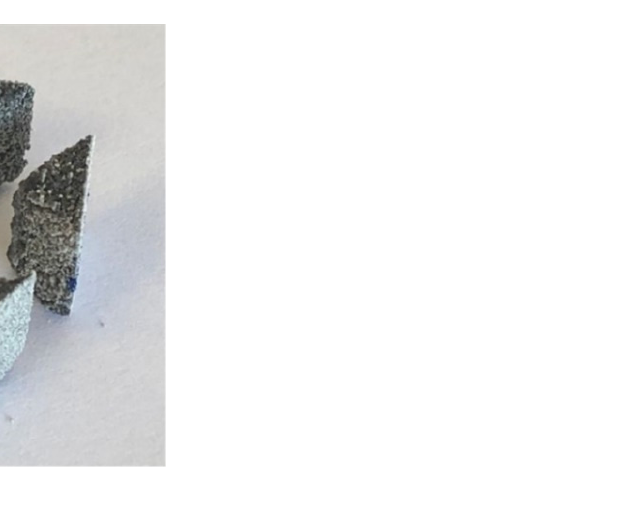
Figure 21 . ( a ) SEM images for linear 0° strategy; ( b ) SEM images for the island strategy; ( c ) SEM images for the concentric strategy; ( d ) separation of alumina sample printed using the concentric strategy.